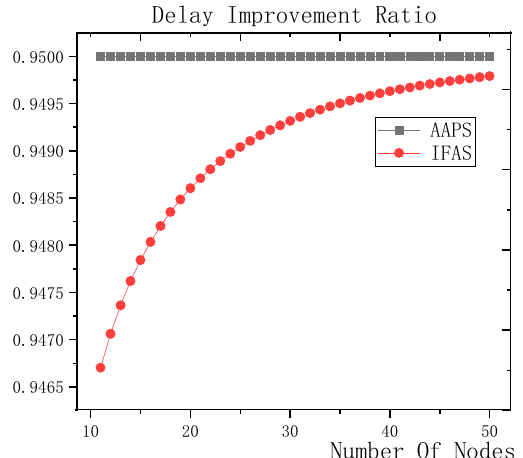
Figure 17. Comparison between IFAS algorithm and AAPS algorithm for transmission delay optimization ( m = 20).